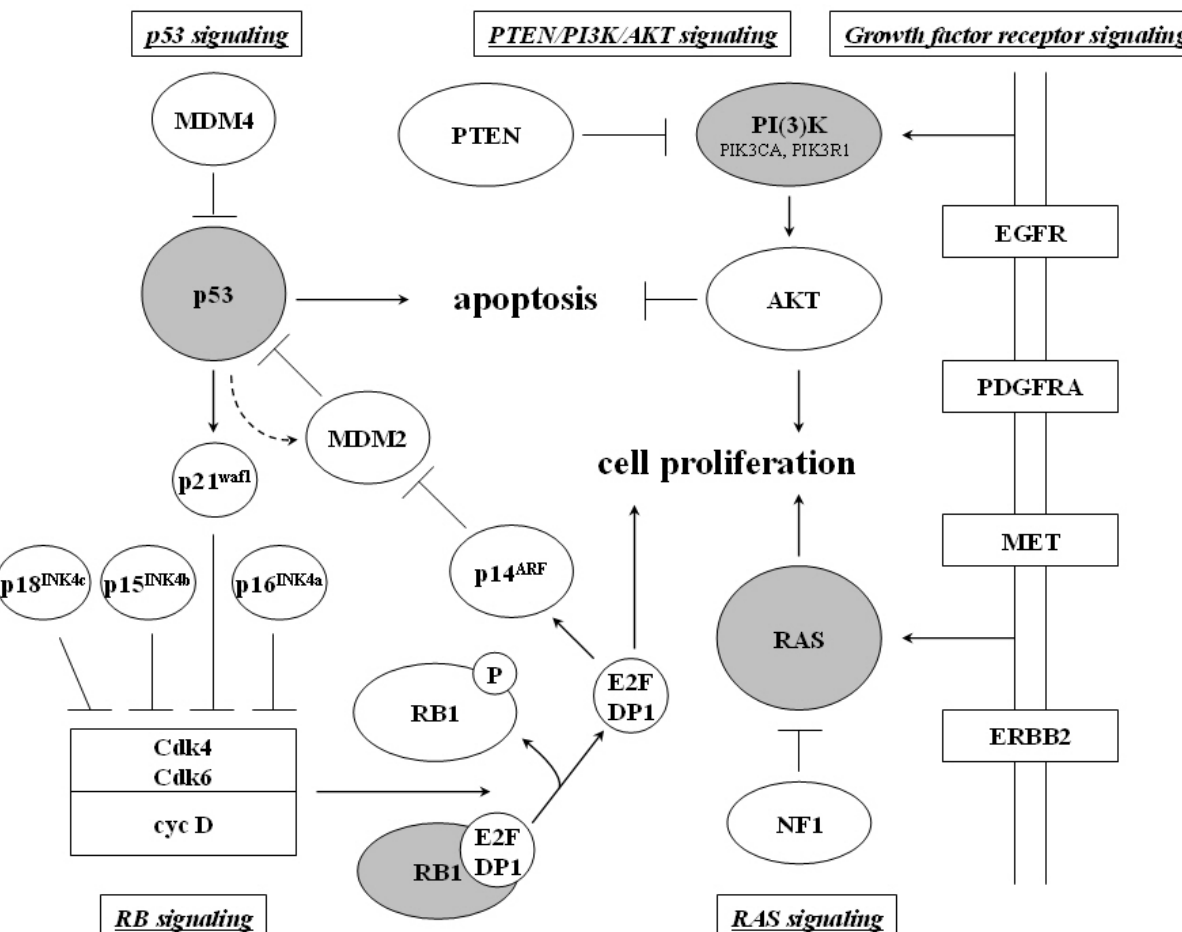
Figure 6. Core pathways involved in the pathogenesis of